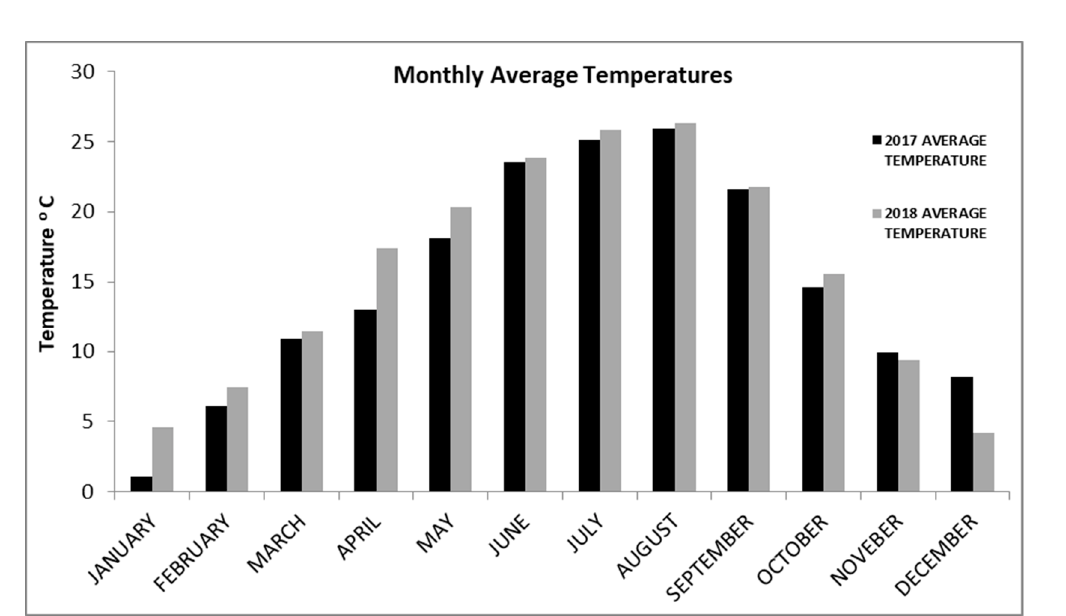
Table 2. Results from One–Way Analysis of Variance (ANOVA) with Tukey’s test, between total phenols and total an- thocyanins in grape berries according to Iland method.